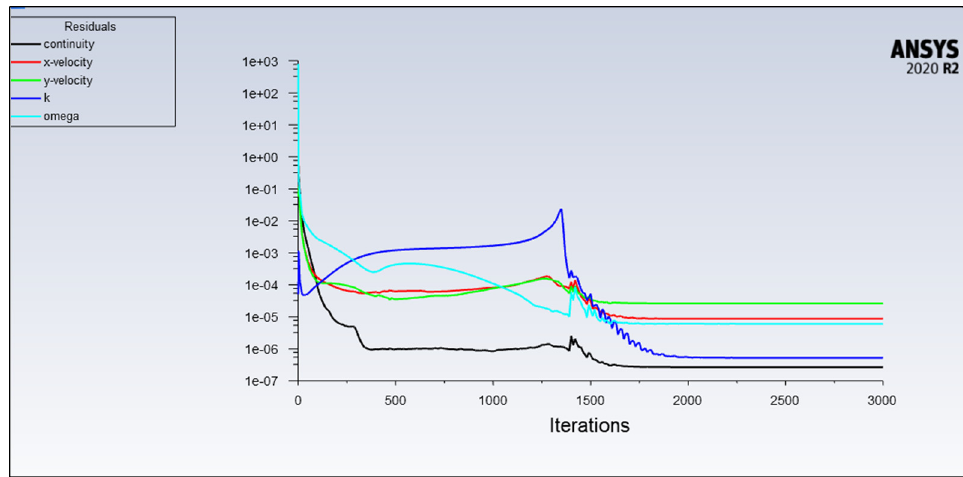
Figure 14. Residuals of CFD analysis.